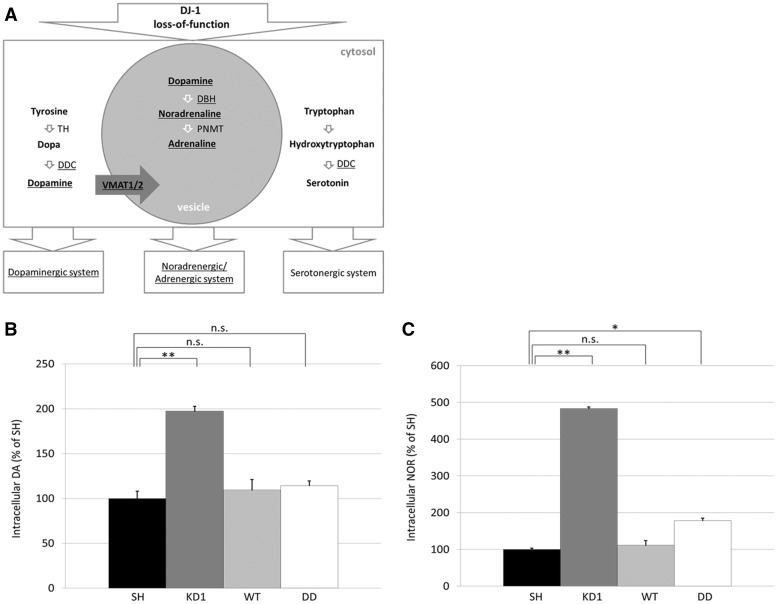
Knock down of DJ-1 affects the dopaminergic and noradrenergic system. (A) Overview of catecholamine synthesis pathways. Abbreviations: tyrosine hydroxylase (TH), dopa decarboxylase (DDC), dopamine beta hydroxylase (DBH), phenylethanolamine-N-methyltransferase (PNMT). (B,C) Results of catecholamine ELISA to measure intracellular levels of dopamine (DA) and noradrenaline (NOR). Catecholamine levels were calculated as pg/mg protein. Results are expressed as percent of SH-SY5Y cells (n = 3). Statistical significance was determined by one-way ANOVA with post hoc Tukey HSD test. *P < 0.05 vs. SH; **P < 0.01 vs. SH; n.s., non-significant.